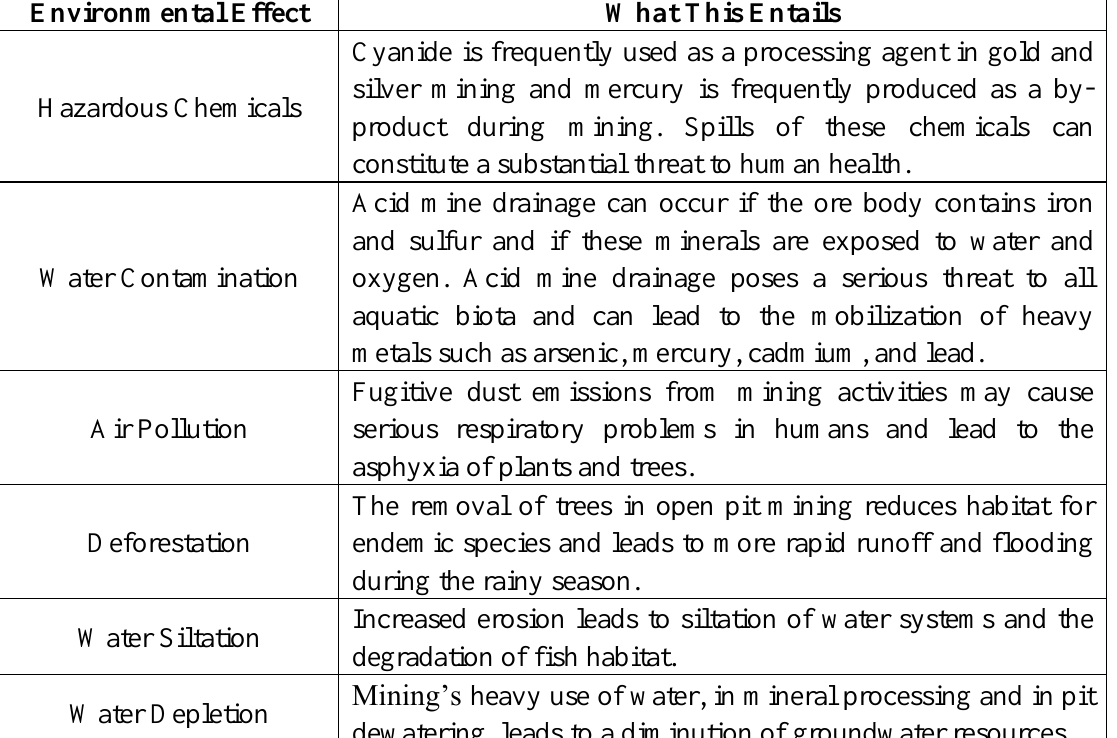
Table 1. Mining‟s Environmental Effects